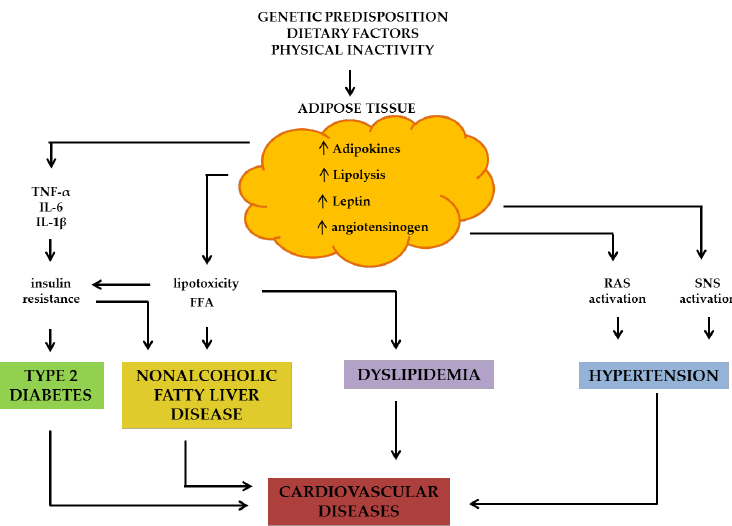
Figure 1. Pathophysiological mechanisms by which excessive adipose tissue leads to metabolic dysfunction and common chronic diseases. RAS: renin-angiotensin system; SNS: sympathetic nervous system; FFA: free fatty acids; IL-6: interleukin-6; IL-1β: interleukin-1β; TNF-α: tumor necrosis factor-α.